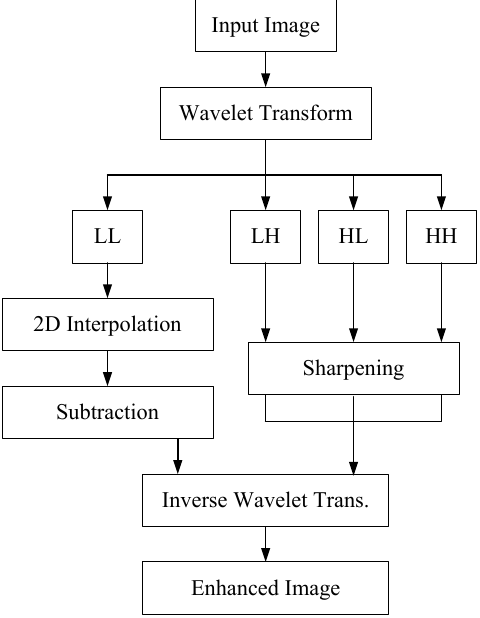
Fig. 1. System overview: integration of context recognition with web-based learning system to extract user